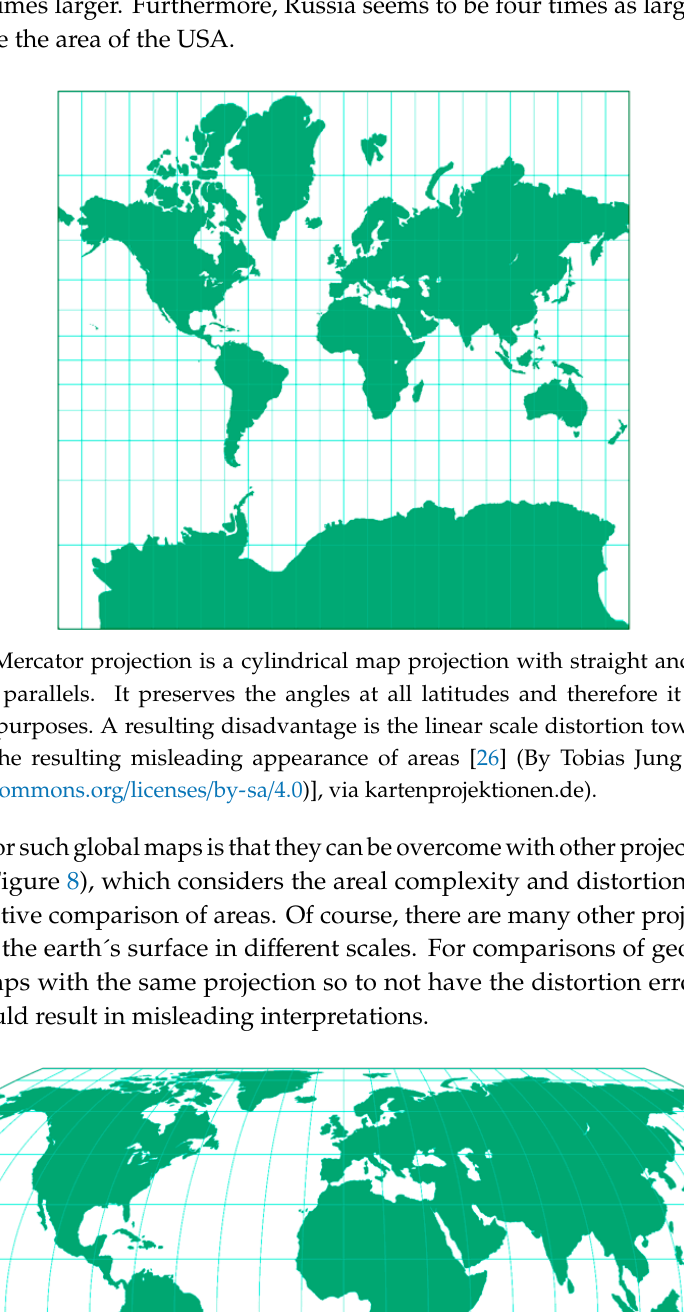
Figure 8. The Equal Earth Projection is an equal area pseudo-cylindrical map projection that is able to preserve the relative size of areas independently of their latitude [27]( By Tobias Jung [CC BY-SA 4.0 (http://creativecommons.org/licenses/by-sa/4.0)], via kartenprojektionen.de).